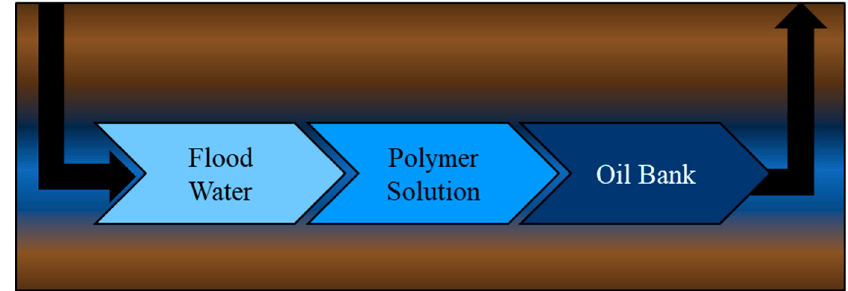
Figure 1. Simplified schematic of the polymer flooding process for enhanced oil recovery.